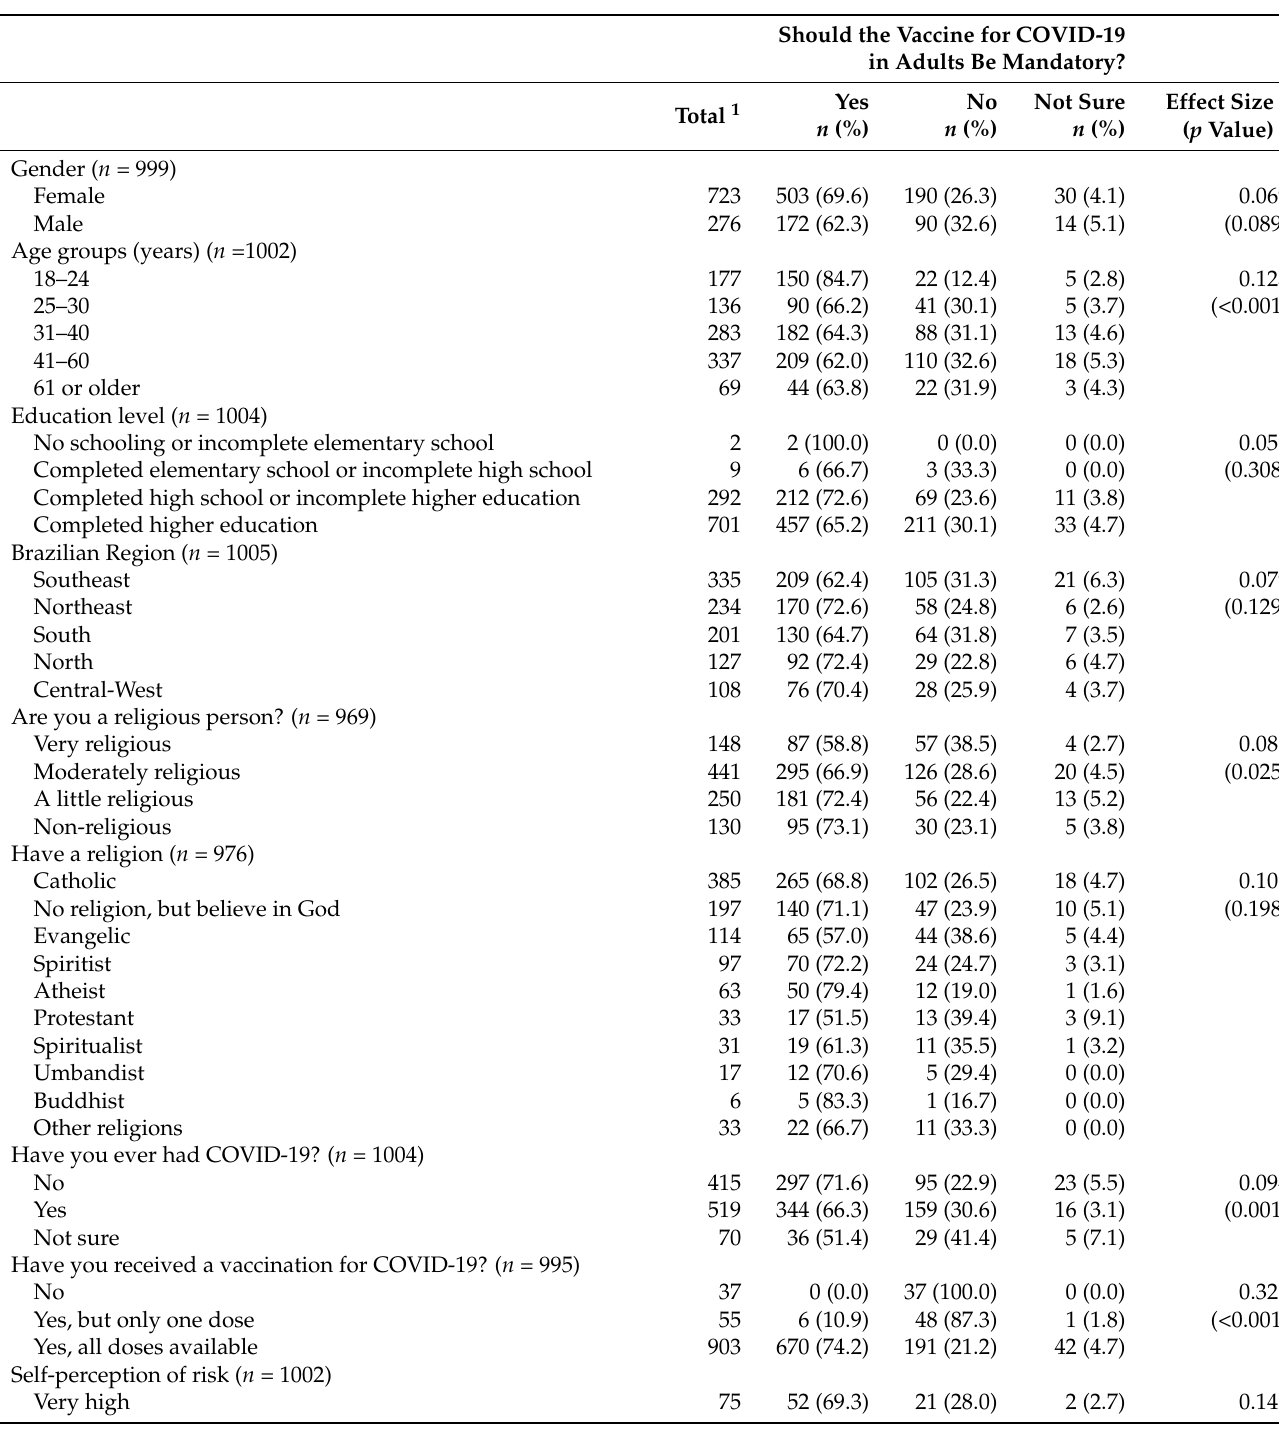
Table 2. Distribution of participants regarding views about mandatory vaccination for COVID-19 in